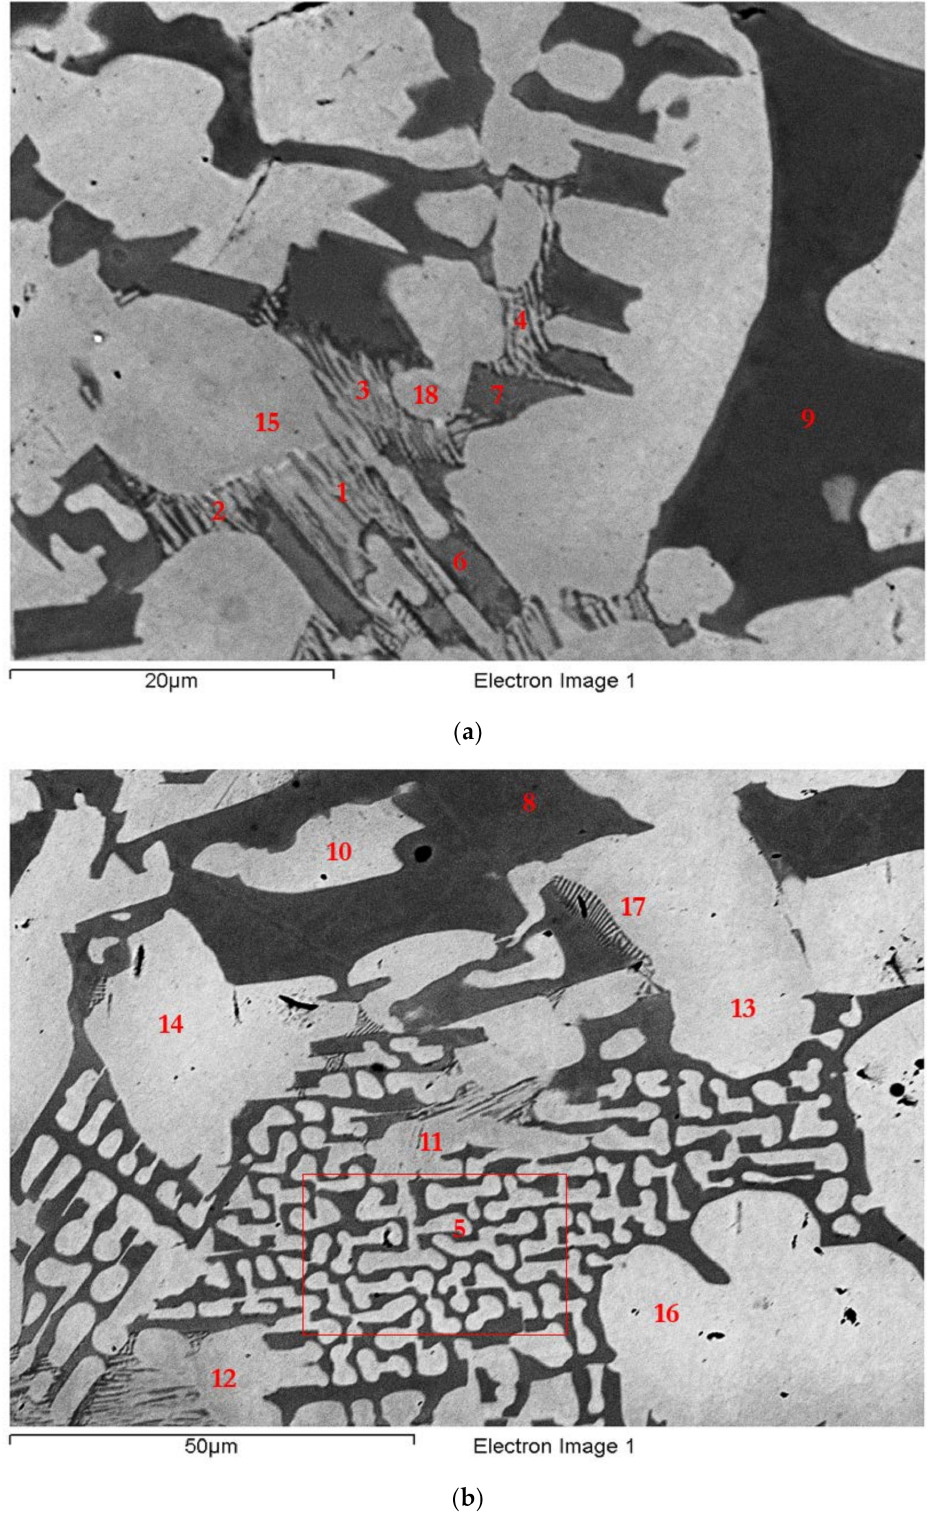
Figure 2. ( a , b ) show details of the microstructure in some parts of the bulk of the ingot of EZ2-AC. See text for